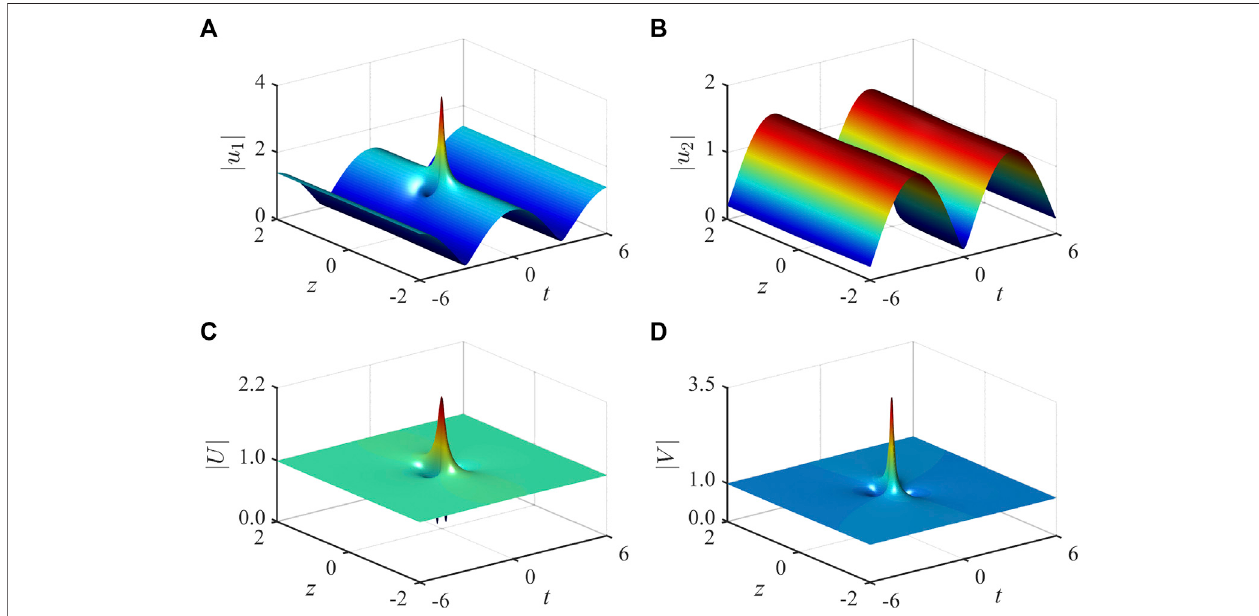
FIGURE 2 | Peregrine soliton states on a periodic background, with (A) an anomalous amplitude enhancement on the u 1 fi eld component, and (B) a heavy falling- off on the u 2 fi eld component, formed in the anomalous dispersion regime ( σ (cid:2) 1 ) . The initial parameters are speci fi ed by c (cid:2) 1, a 1 (cid:2) ω (cid:2) − 1 / 2, μ (cid:2) − 2, and ] (cid:2) 1 2